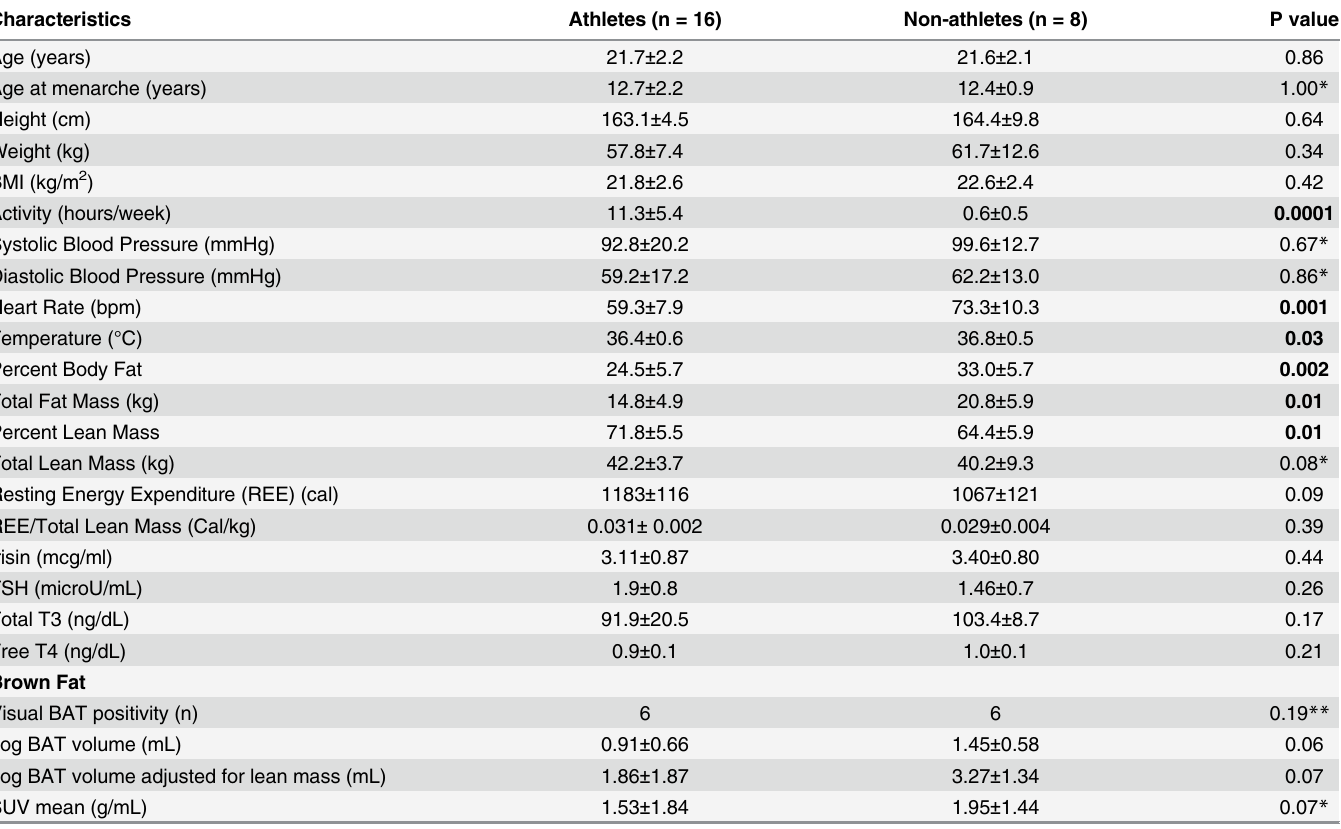
Table 1. Baseline and Brown Fat Characteristics Athletes and Non-athletes (NA).